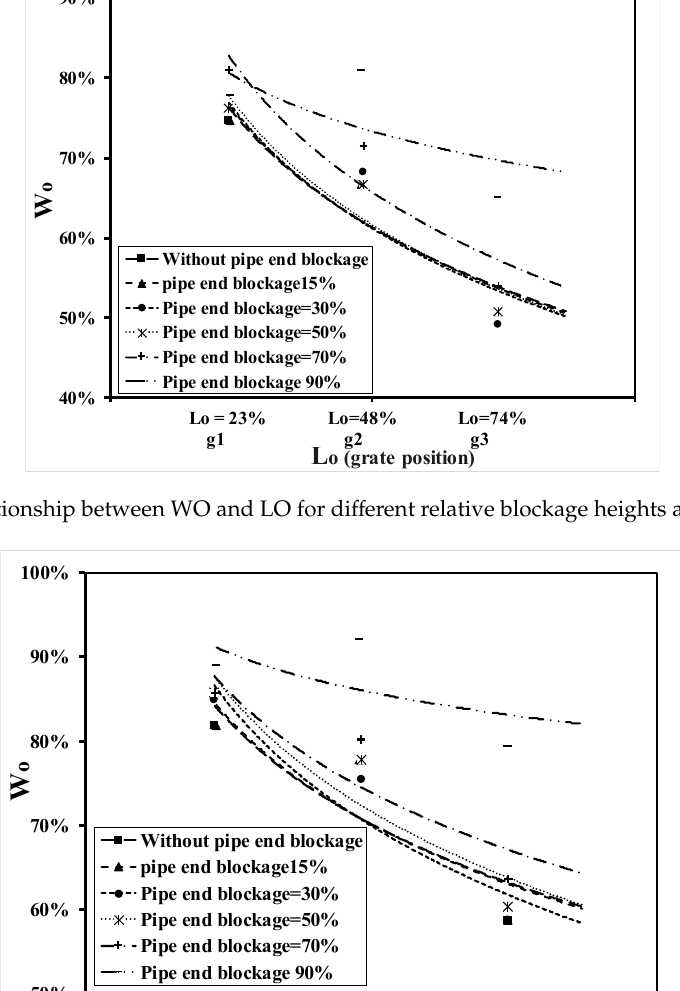
Figure 15. ( A ) The blockage along main pipe length and ( B ) end pipe blockage.